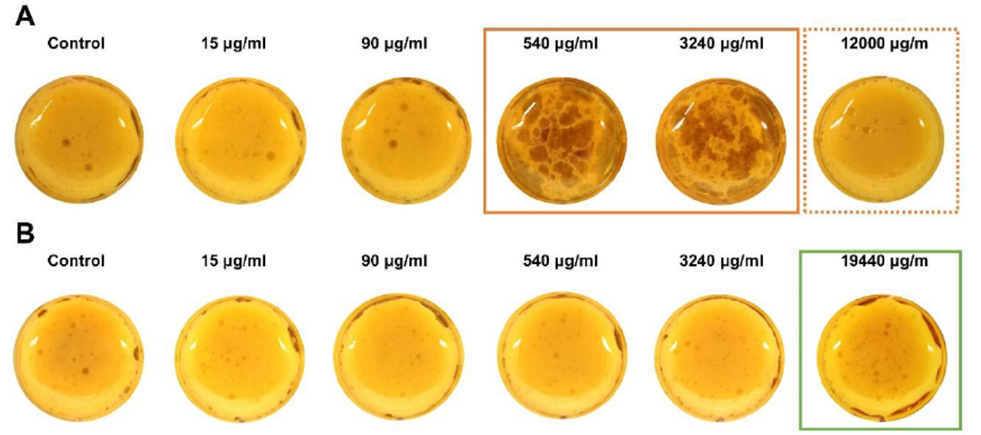
Figure 1. Gross morphology of adipocytes. ( A ) Adipocytes treated with clindamycin. The orange frame marks the appearance of ruptured adipocytes for group AB3 and AB4. The dashed frame indicates the paradox effect of the highest clindamycin dose with intact adipocytes. ( B ) Adipocytes treated with cefazolin. The green frame marks ruptured adipocytes in group AB5.